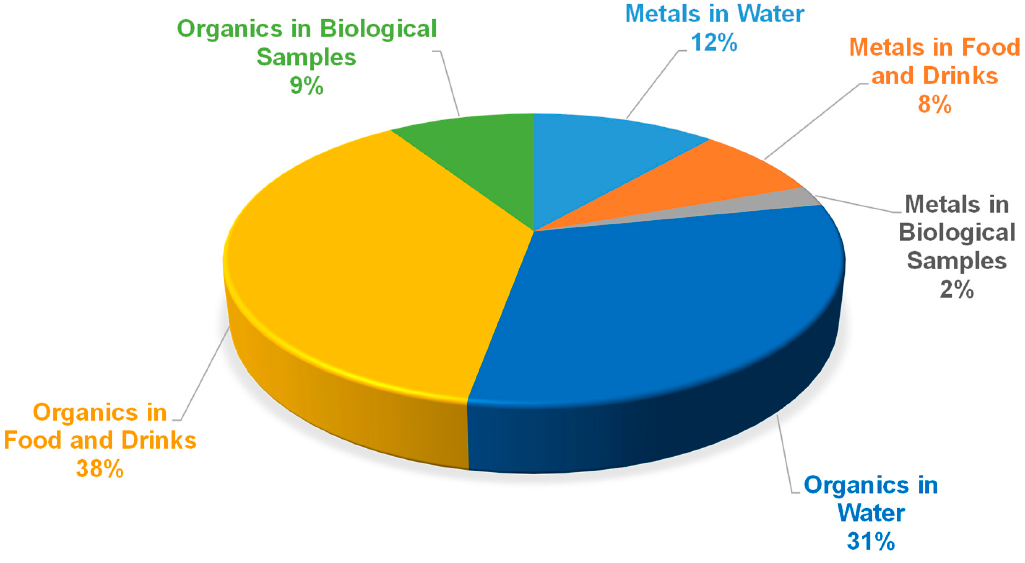
Figure 4. Percentage distribution of the published papers (2010–2020) on eutectic solvents in the development of analytical methods as a function of the application.